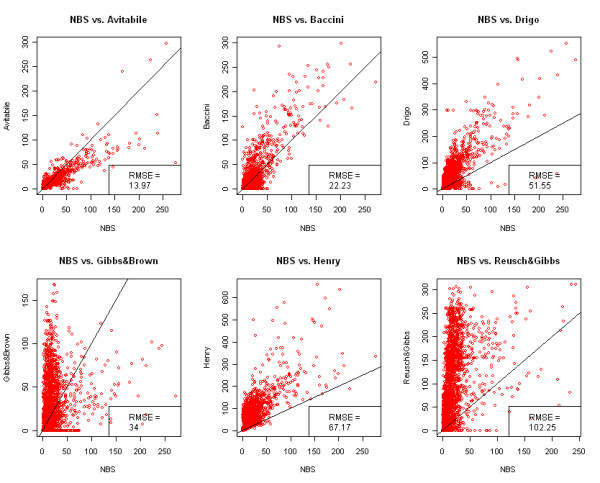
Comparison of AGB values between the NBS and the other biomass maps. The comparison is performed at pixel level and the results are reported for the maps aggregated at 10 Km resolution for graphical reasons. AGB is reported in Mg ha-1. RMSE: root mean square error.